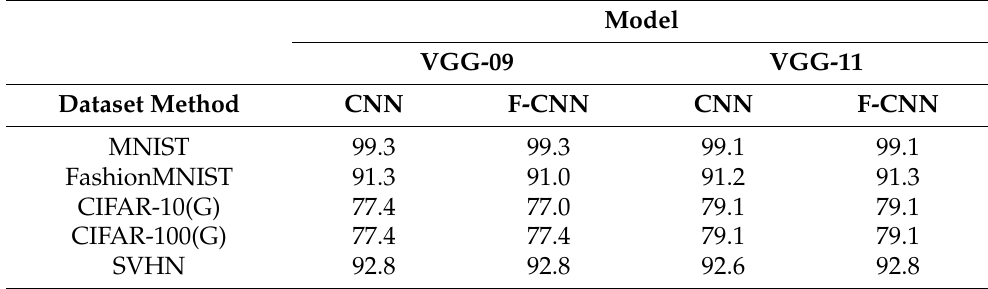
Table 4. Accuracy (%) of VGG-09 and VGG-11 on gray-scale image